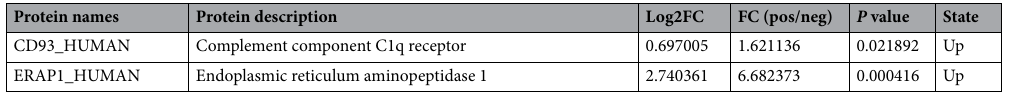
Table 2. Differential protein information.